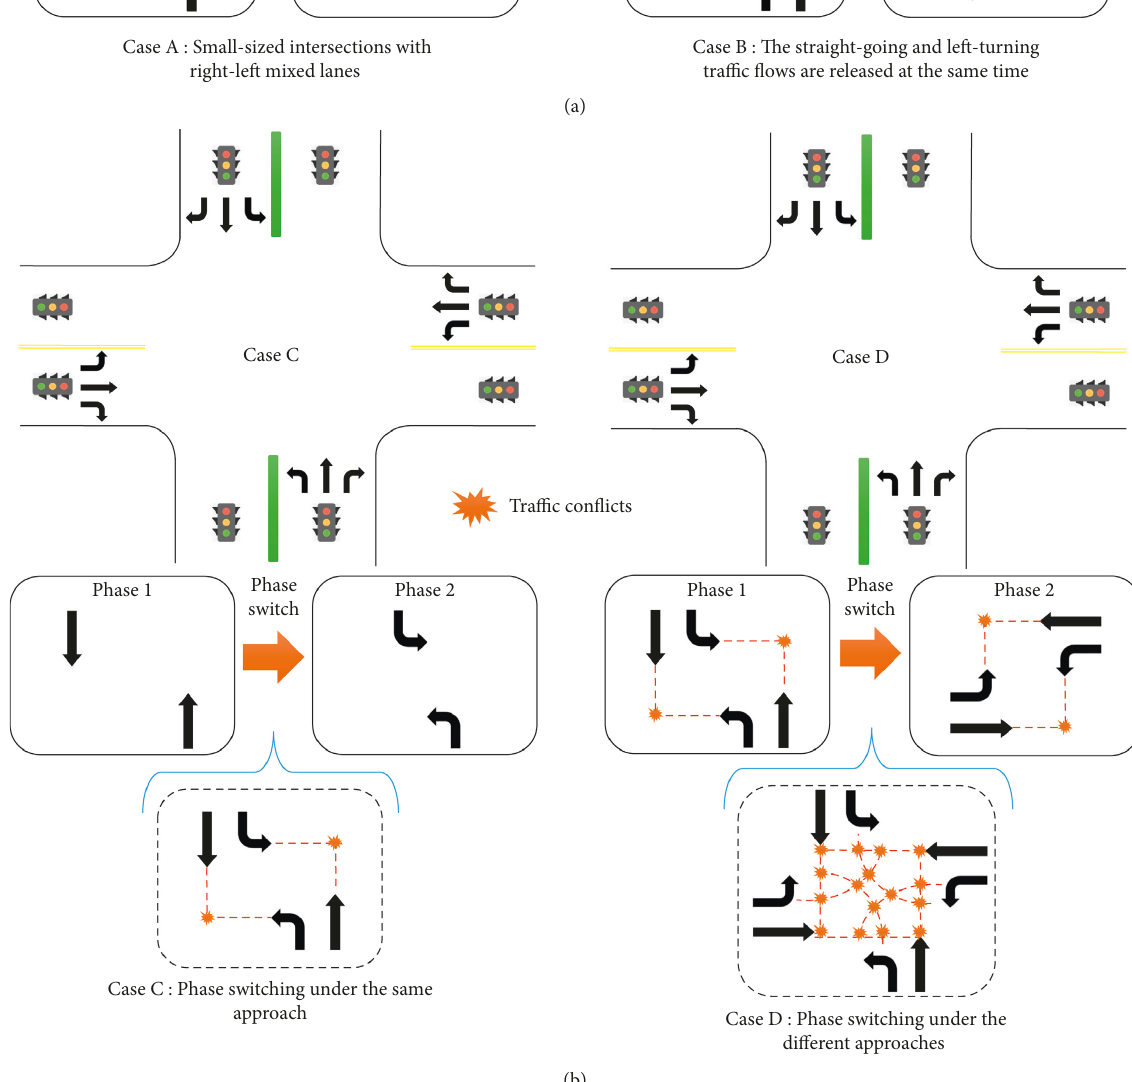
Figure 1: The traffic conflicts of some signalized intersections in one signal cycle. (a) Two common cases of traffic conflicts at signalized intersections during a phase. (b) Two common cases of traffic conflicts at signalized intersections during the phase